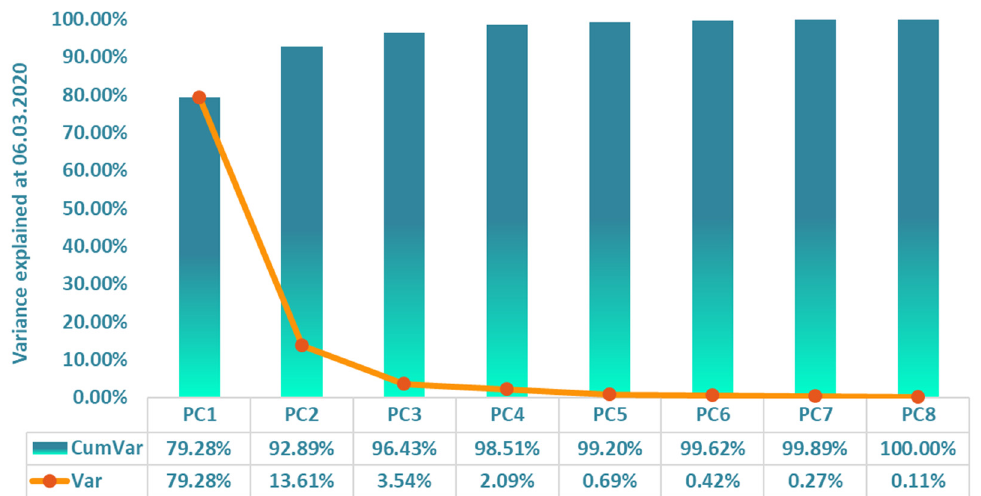
Figure 6. Yield curve variability explained by principal components on 6 March 2020. Source: Bloomberg, own computation of PCs with the use of a VBA add-in developed by Leonardo Volpi.